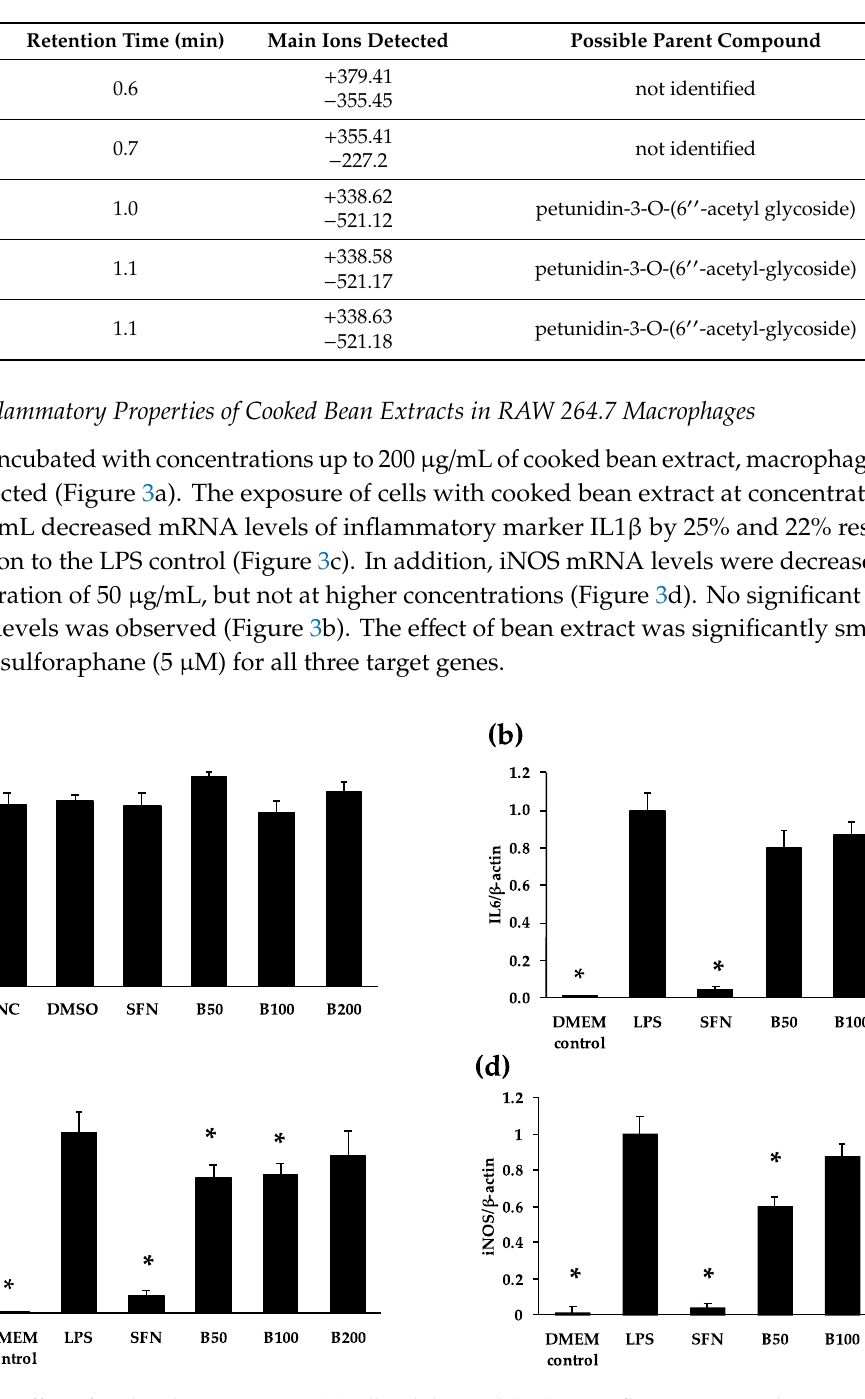
Figure 3. Effect of Borlotti bean extract on ( a ) cell viability and ( b – d ) pro-inflammatory cytokine expression in macrophages. ( a ) Murine RAW264.7 macrophages were incubated with 50, 100 and 200 µg/mL as well as 5 µM sulforaphane (SFN) and DMSO (1%) and cell viability was assessed by neutral red assay. Negative control (NC) refers to DMEM medium only. ( b ) Effect of Borlotti bean extracts on mRNA inflammatory target genes IL6 ( b ), IL1- β ( c ) and iNOS ( d ). Macrophages were incubated with 50 (B50), 100 (B100) and 200 µg/mL (B200) cooked Borlotti bean extract and stimulated with LPS (100 ng/mL). Controls used were unstimulated medium control (DMEM), LPS-stimulated control (LPS) and sulforaphane (5 µM) control (SFN). * indicates statistically different values among samples according to a post-hoc comparison (Dunnett’s test) at p < 0.05.